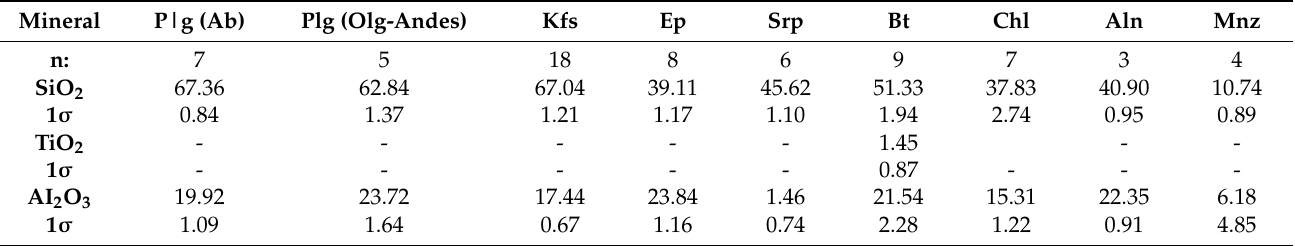
Figure 2. Photomicrographs from optical microscopy showing the textural characteristics of the SE Mesohellenic Trough sandstones and backscattered images (BSI) from SEM: ( a ) photomicrograph of clastic texture presented in medium-grained sandstone with quartz (Qz), plagioclase (Plg), muscovite (Ms), and calcite (Cc); ( b ) BSI of smectite formation over K-feldspar; ( c ) photomicrograph of clastic texture presented in a coarse-grained sandstone with quartz (Qz), K-feldspars (K-Fs), and calcite (Cc); ( d ) BSI showing alteration of K-feldspar into clays; ( e ) photomicrograph of clastic texture represented in fine-grained sandstone with quartz (Qz), K-feldspars (K-Fs), muscovite (Ms), and calcite (Cc); ( f ) BSI showing alteration of K-feldspars and plagioclase into clay minerals. Table 1. Average and 1σ standard deviation mineral chemistry values of selected sandstone samples from the geological Pentalofos Formation. Abbreviations: Plg: plagioclase, Ab: albite, Olg: oligoclase, Andes: Andesine, Kfs: K-feldspar, Ep: epidote, Srp: serpentine, Bt: biotite, Chl: chlorite, Aln: alanite, Mnz: monazite.